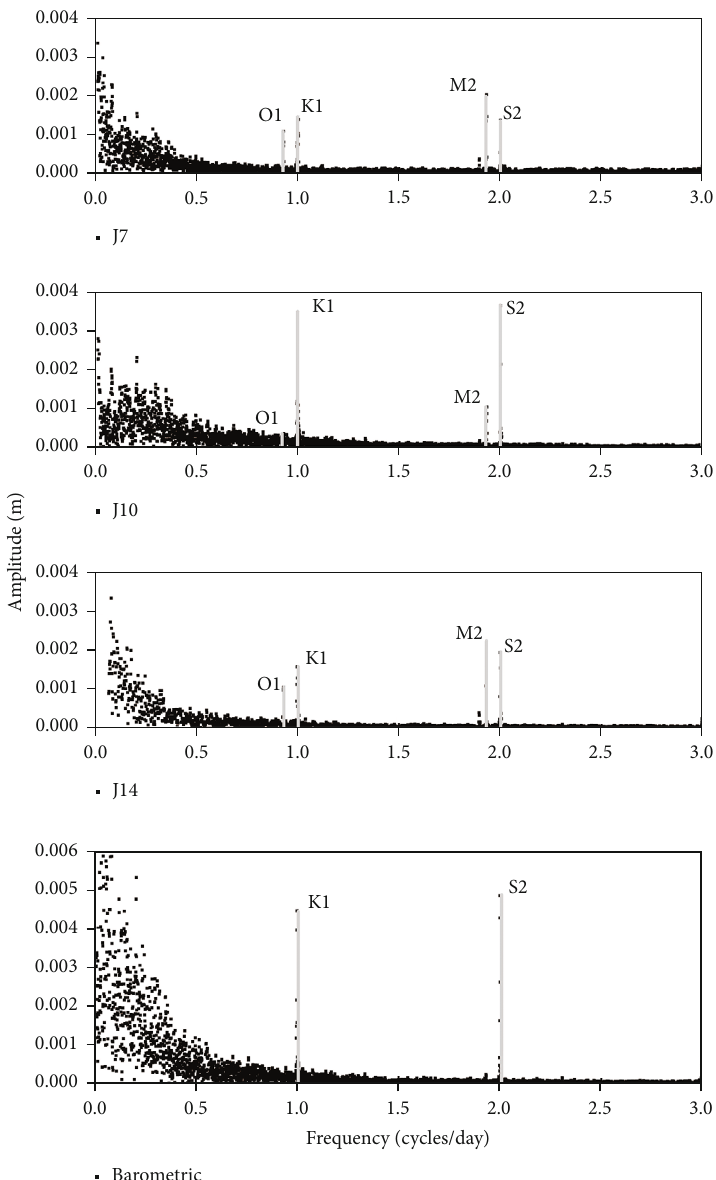
Figure 6: The amplitude spectrum of water level and barometric pressure data from September 2015 to September 2017. The vertical gray lines indicate the K1, O1, M2, and S2 tidal